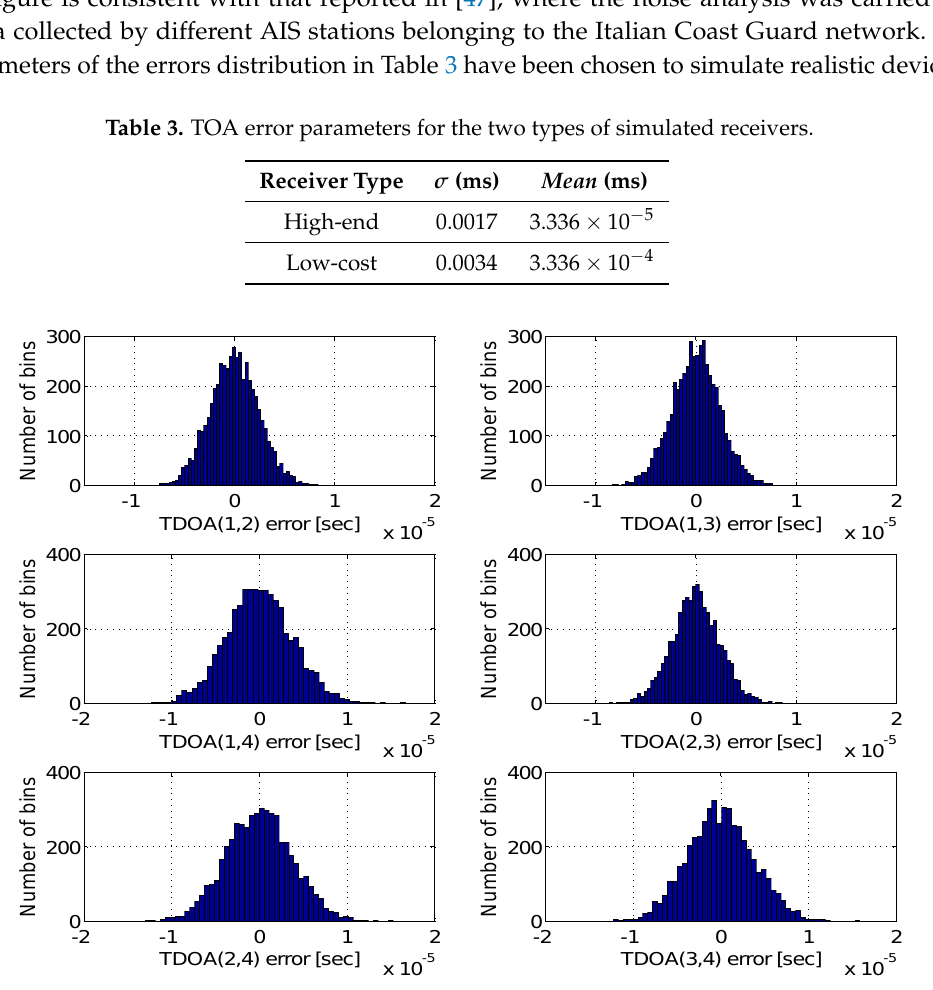
Figure 5. TDOA error distribution between couples of receivers. Three synchronised receivers (1–3) and one non-synchronous receiver (4) are considered. The Gaussian bells relative to TDOA errors that include receiver number 4 appear larger than the